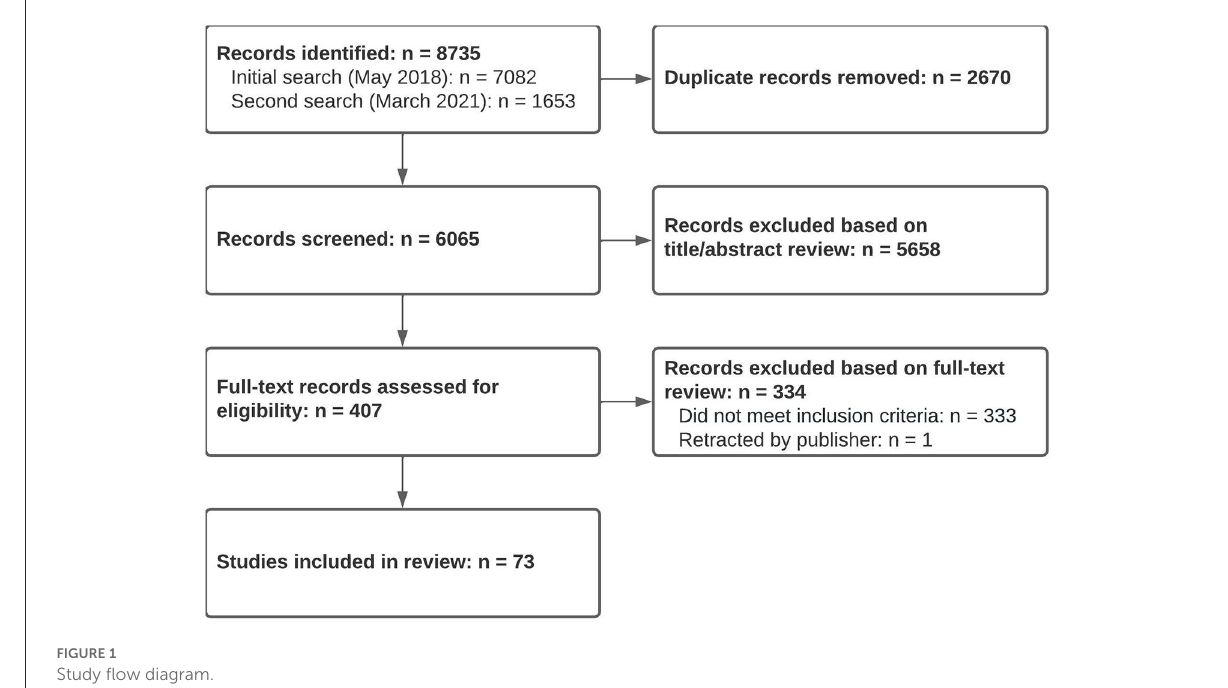
FIGURE1 Study flow diagram.